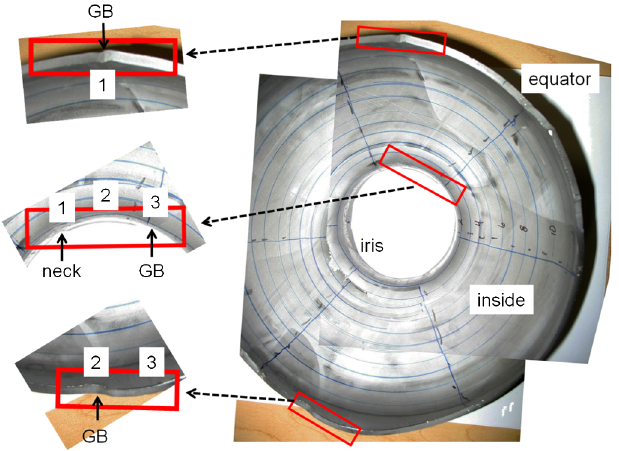
FIG. 2. Locations where the three specimens were extracted from a half cell provided by Jefferson Lab. Grain boundaries (GB) and a neck are indicated in the blown-up images on the left. Numbers mark roughly where each EBSD scan was done on the equator/iris (in cross reference with Fig. 4). The concave side is the inside of a cavity, and the opposite is the